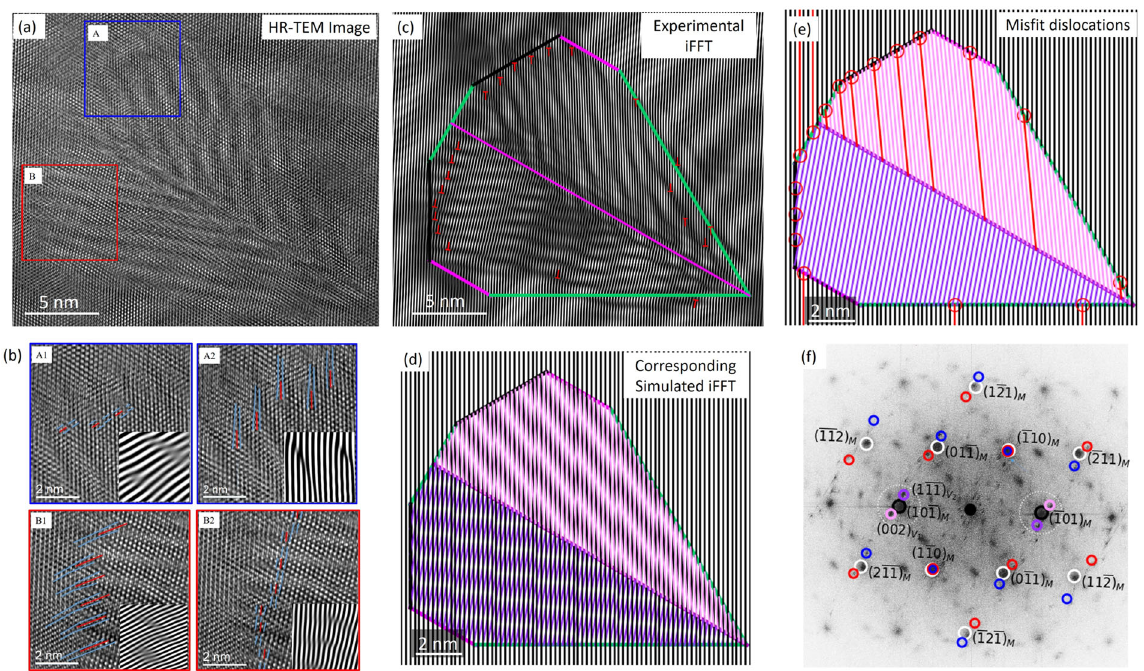
Fig. 3 The demonstration that additional lattice sites are created within semi-coherent precipitates of irradiated Fe – Ni. a HRTEM image of the fcc variants formed under irradiation at 400 °C at a fl ux of 9.6 10 − 6 dpa s − 1 within the Fe-3.3 at% Ni bcc matrix. fcc variants and bcc matrix are respectively in [110] and [111] zone axis. The schematic shape of the precipitate is superimposed. Interfaces with the invariant plane orientation, ð 1 (cid:1) 10 Þ M , are in violet, (112) M and (110) M orientated interfaces are respectively in green and black. b Enlargement of two series of dislocation mis fi ts between (A1) the ð 01 (cid:1) 1 Þ M matrix planes and the ð (cid:1) 111 Þ V1 planes of variant 1 (half top of the precipitate); (A2) the ð 10 (cid:1) 1 Þ M matrix planes and the (002) V1 planes of variant 1 (half top of the precipitate); (B1) the ð 01 (cid:1) 1 Þ M matrix planes and the ð 00 (cid:1) 2 Þ V2 planes of variant 2 (half bottom of the precipitate); (B2) the ð 10 (cid:1) 1 Þ M matrix planes and the ð 1 (cid:1) 1 (cid:1) 1 Þ ð 10 (cid:1) 1 Þ V2 planes of variant 2 (half bottom of the precipitate). c Inverse Fast Fourier Transform (iFFT) of the M matrix planes and (002) V1 planes of variant 1 (half top of the precipitate in pink) and the ð 1 (cid:1) 1 (cid:1) 1 Þ V2 planes of variant 2 (half bottom of the precipitate in violet). d , e Simulated iFFT corresponding to the image ( c ). The representation of ð 10 (cid:1) 1 Þ M matrix planes, (002) V1 precipitates planes of variant 1 and ð 11 (cid:1) 1 Þ V2 precipitate planes of variant 2 in black, pink, and violet, highlight the atomic plane discontinuities, which may lead to the formation of dislocation mis fi ts at interfaces (the extra planes are indicated as red lines and discontinuities at interfaces as red open circles). The superposition of the same matrix and precipitate planes yields Moire fringes, whose periodicity along an interface corresponds to the dislocation mis fi t periodicity. f Superposition of the experimental and simulated FFT of both the matrix and the precipitate. The Wulff-radius of interface normalized by the ð (cid:1) 110 Þ M interface radius is equal to: E (cid:1) 12 (cid:1) 1 ¼ E (cid:1) 211 ¼ 0 : 6, and E 11 (cid:1) 2 ¼ E 01 (cid:1) 1 ¼ E 10 (cid:1) 1 ¼ 1 :